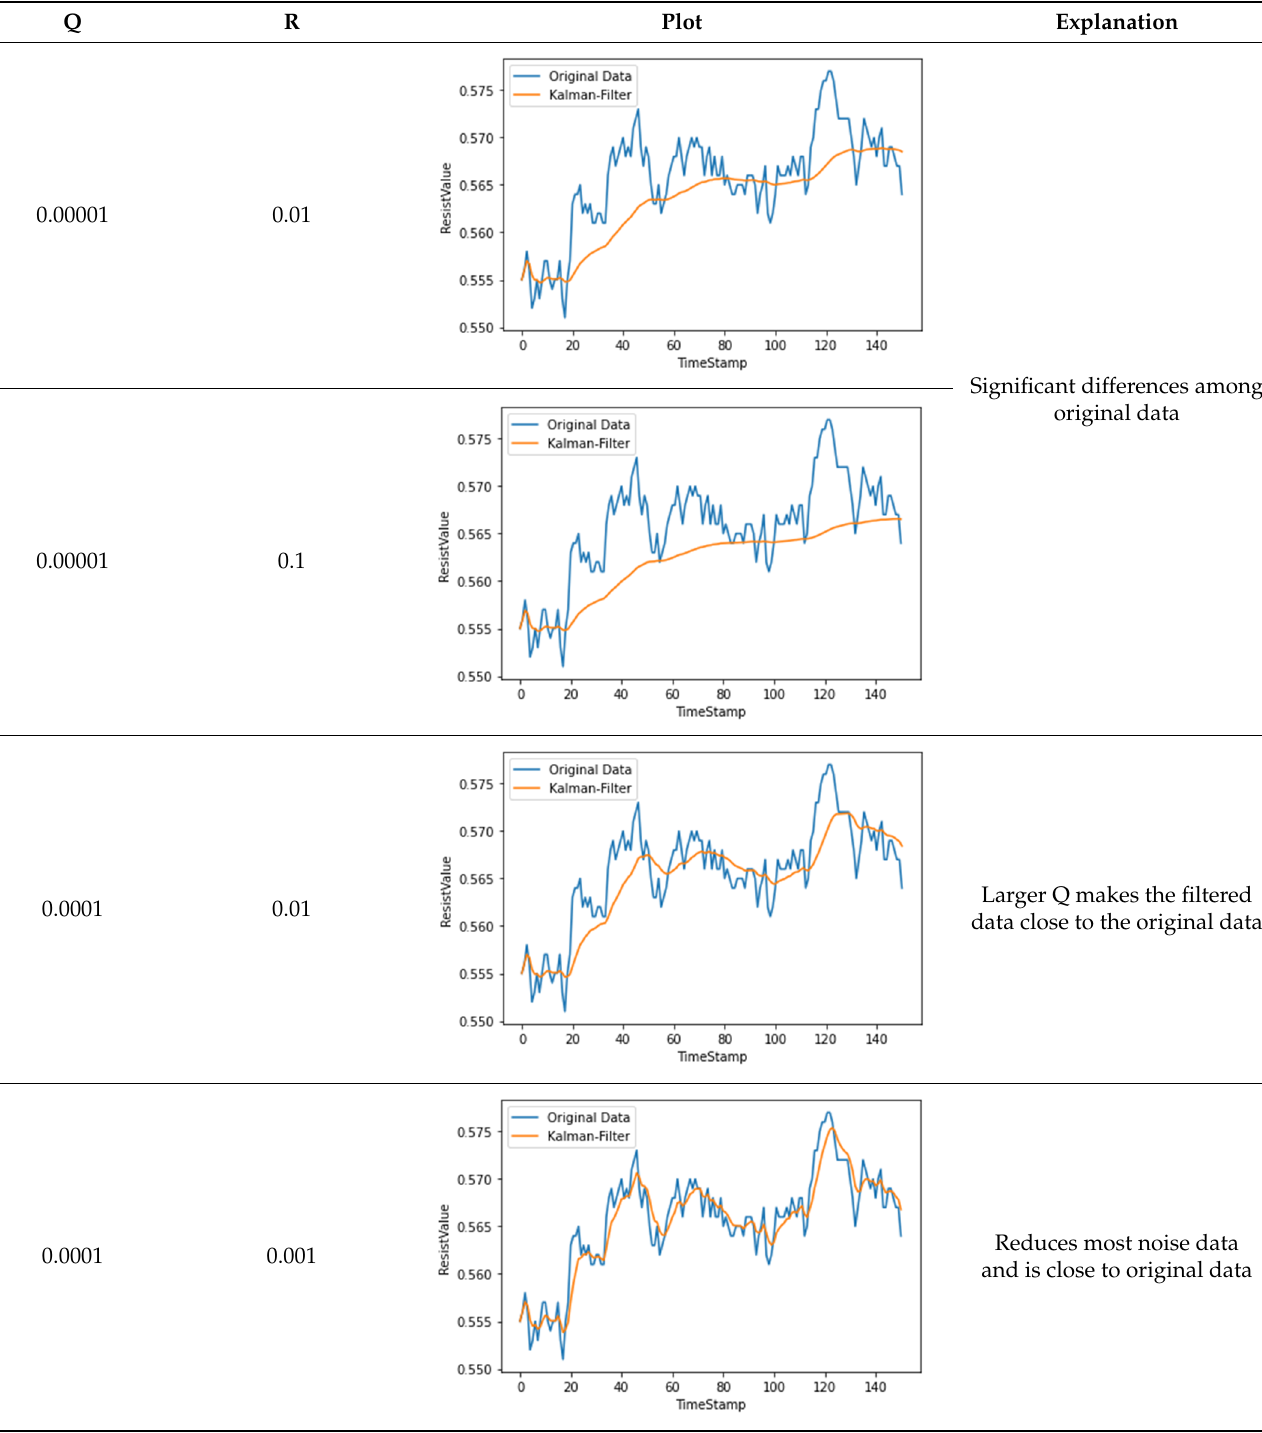
Table 2. Hyperparameters used for Kalman filter.